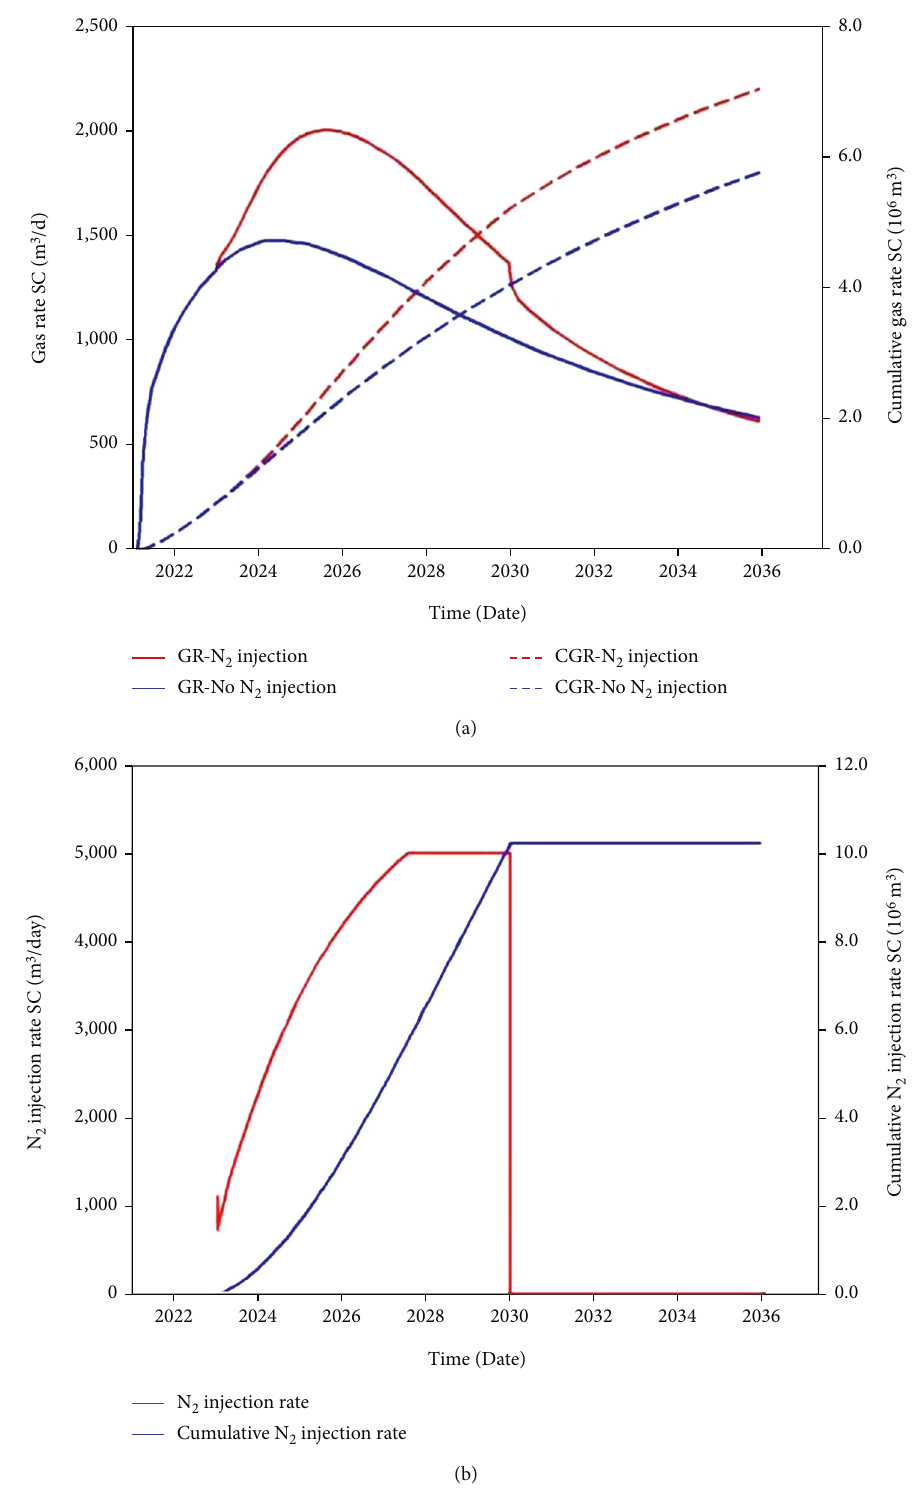
Figure 7: The CBM production curves and N GR denotes daily gas production, and CGR denotes cumulative gas production. SC denotes surface